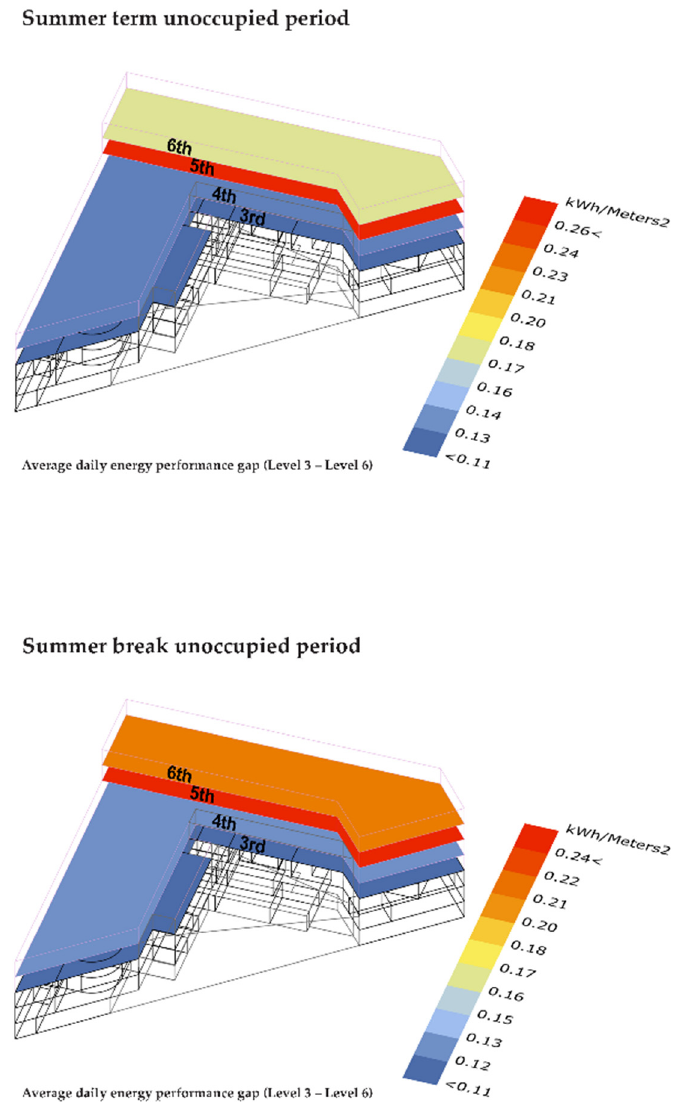
Figure 8. Average daily energy performance